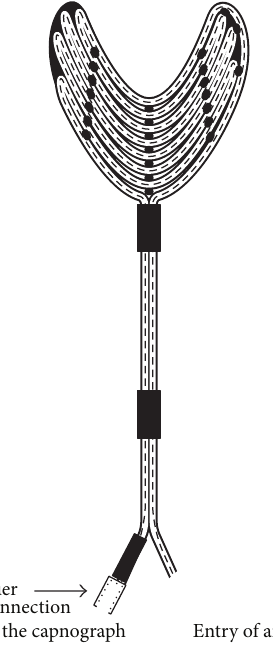
Figure 1: Scheme of the sublingual